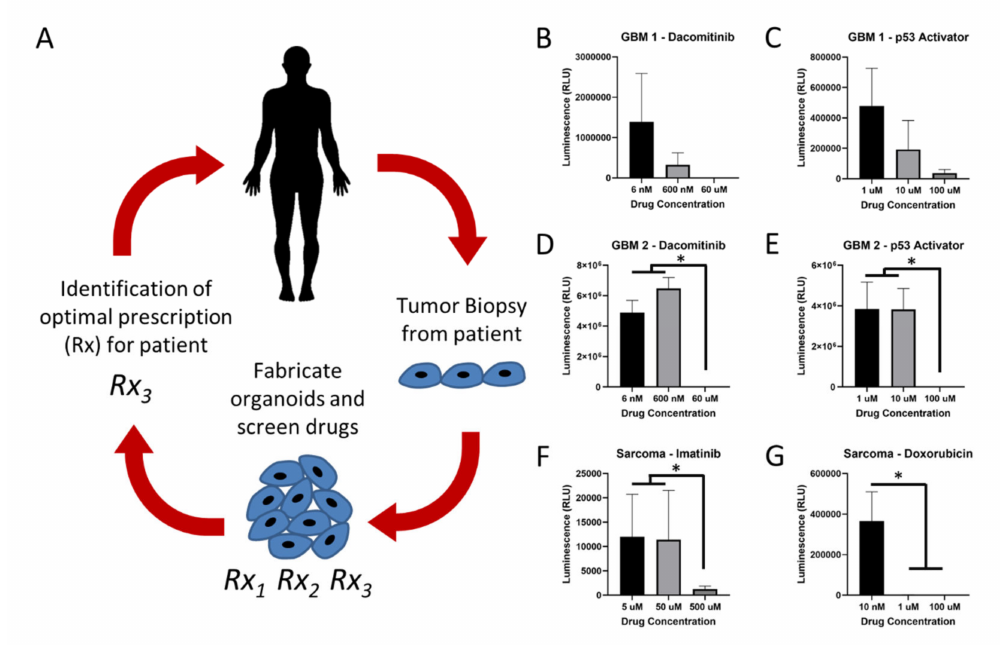
Figure 5. Employing bioprinted patient-derived tumor organoids in a clinical precision medicine setting. ( A ) Tumor tissue is removed from a patient as a biopsy or during surgery. The biospecimen is then dissociated and biofabricated into sets of small organoids or tumor constructs using hydrogel bioinks, after which empirical drug response data can be generated during chemotherapy screening studies. Resulting drug response data can be used to help predict which drugs might be most e ff ective for that specific patient. ( B – G ) ATP quantification representing cell viability following chemotherapy screens in